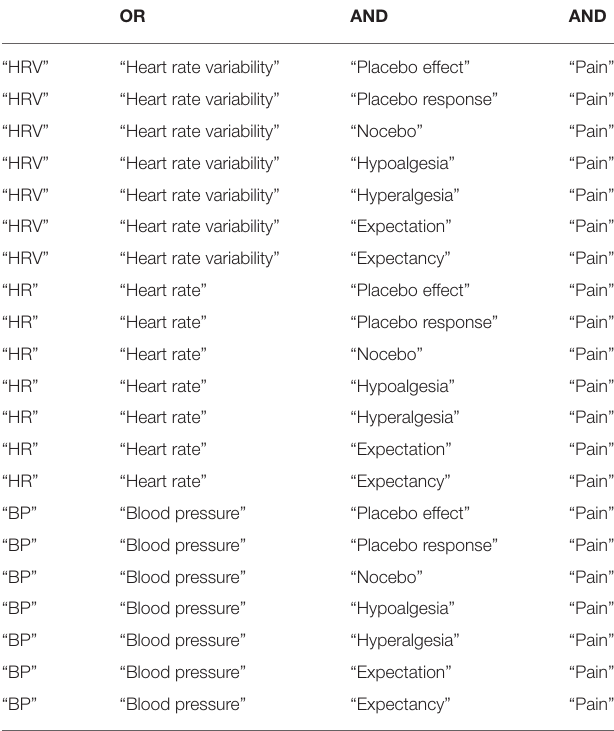
TABLE 1 | Boolean terms used to search